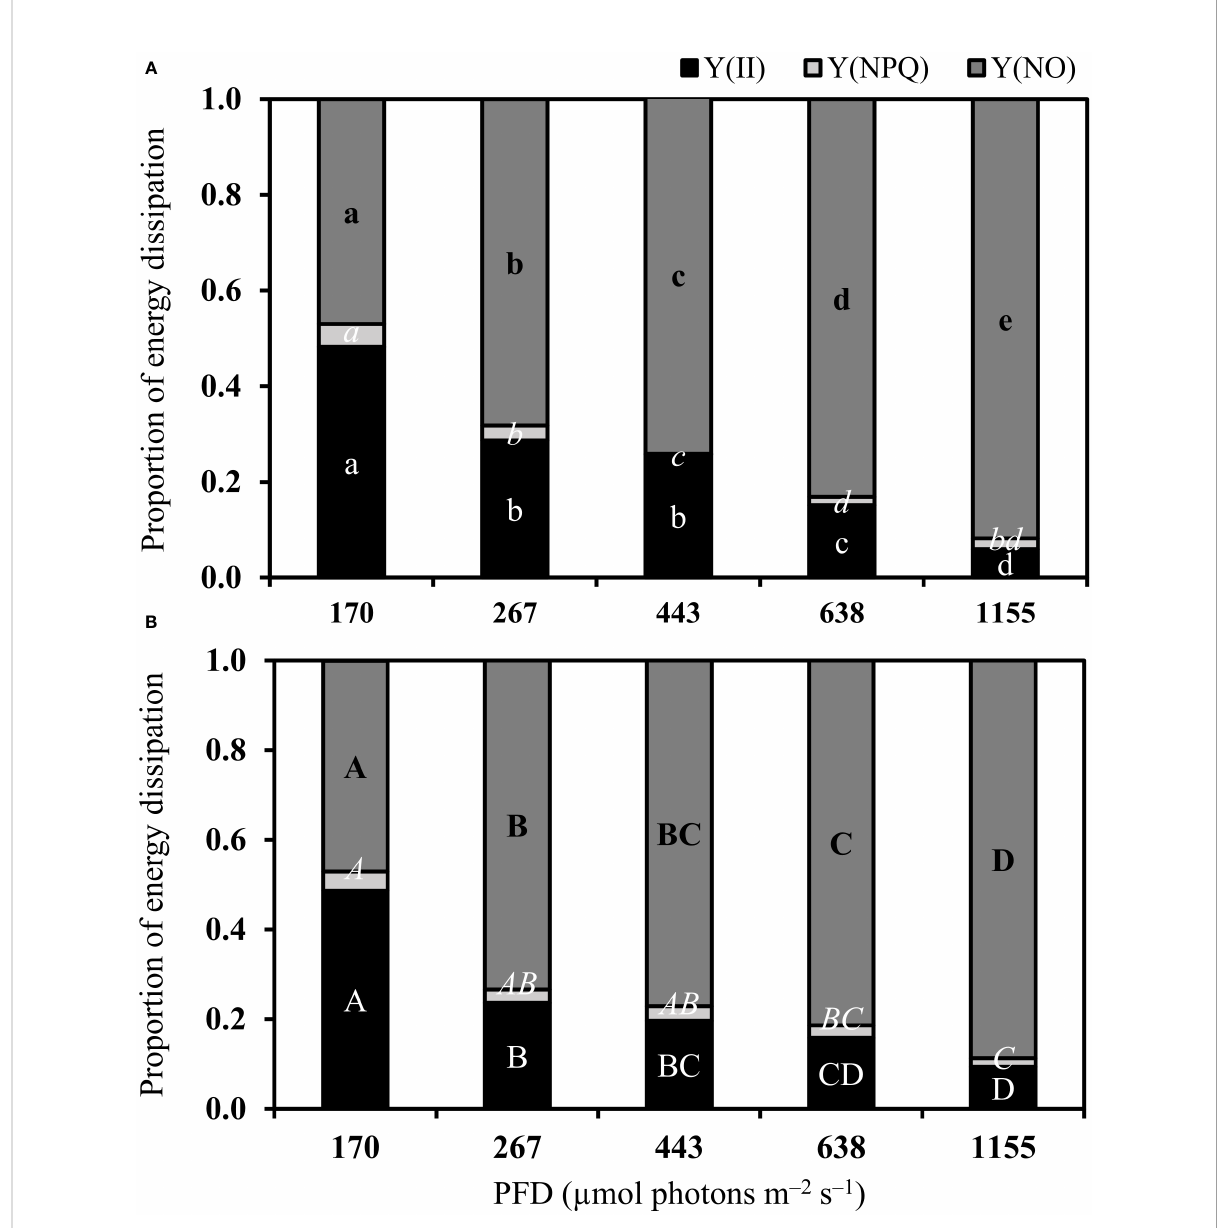
FIGURE 4 Complementary energy dissipation pathways in photosystem II of Bostrychia calliptera (A) and B. montagnei (B) cultured under different photon fl ux densities (PFDs) for 14 days. Columns are mean proportions of energy dissipation based on four replicates ( n = 4). Y(II) is the photochemical pathway, Y(NPQ) is the regulated non-photochemical quenching of light energy, and Y(NO) is the non-regulated non-photochemical quenching of light energy. Bostrychia calliptera (A) : different regular, italic, and bold lowercase letters indicate statistical differences ( p< 0.05) for Y(II), Y(NPQ), and Y(NO), respectively, among PFD treatments. Bostrychia montagnei (B) : different regular, italic, and bold uppercase letters indicate statistical differences for Y(II), Y(NPQ), and Y(NO), respectively, among PFD treatments. Statistical differences were found applying one – way ANOVA or Kruskal – Wallis ’ test (Table S1) followed by associated post hoc